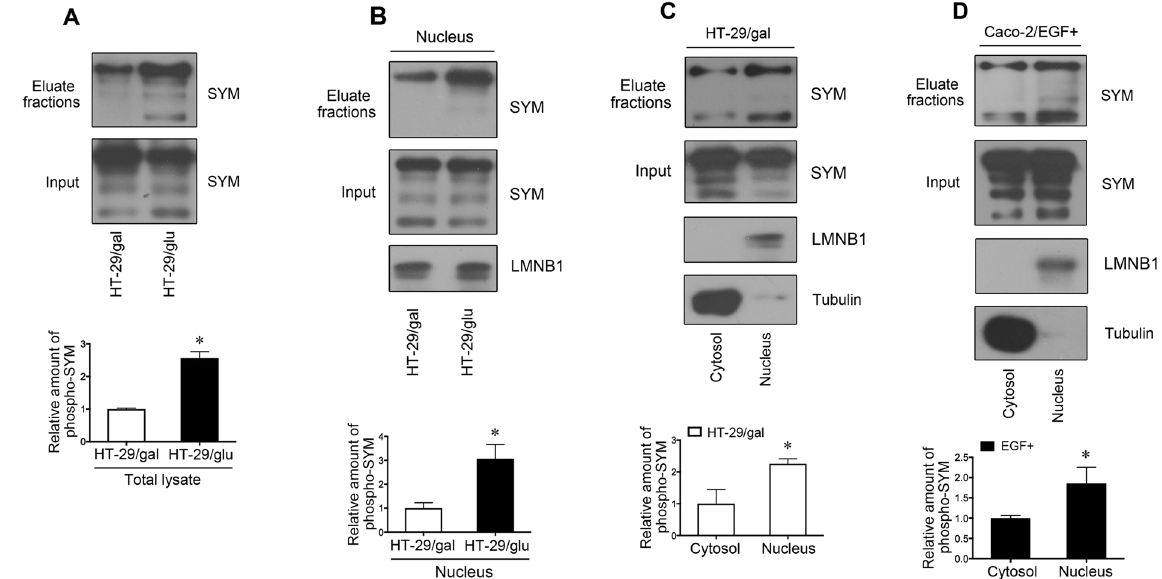
Figure 4. Determination of phosphorylated symplekin in cells. ( A ) Cell protein extraction, phosphoprotein purification, and WB assay for symplekin (SYM) in HT-29/gal and HT-29/glu cells. ( B ) WB bands of symplekin in nuclear phosphoproteins isolated from HT-29/gal and HT-29/glu cells. ( C ) Comparison of phosphorylated symplekin between HT-29/gal cytosol and nucleus. ( D ) Comparison of phosphorylated symplekin between EGF stimulated Caco-2 cell cytosol and nucleus. Tubulin and LMNB1 were employed to determine the cell fractionation efficiency. Phosphoproteins were isolated from the eluate fraction. Total cell or nuclear proteins before phospho-purification were used as the input. Phosphorylated symplekin was normalized to the levels of input symplekin in total cellular, cytosolic, or nuclear lysates, and graphic representation of relative amount of phosphorylated symplekin (phospho-SYM) was shown in the bottom panels. # P < 0.05, Student’s t-test. Data are means ± SD, n =